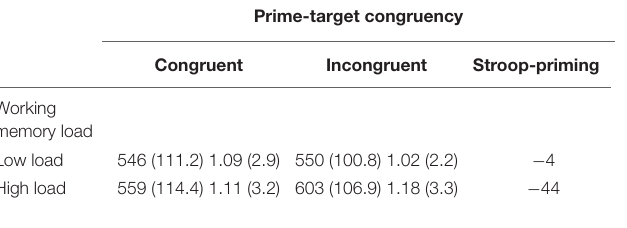
TABLE 1 | Mean (SD) correct reaction times (ms) and error percentages (in %) for congruent and incongruent trials in the Stroop task, under low and high WM load in Experiment 1.